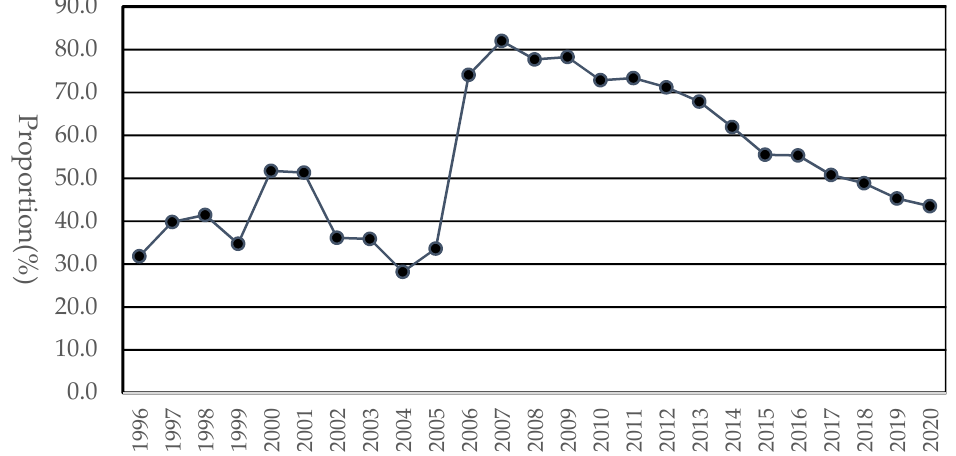
Figure 4. The proportion of low back pain among WMSDs by year.